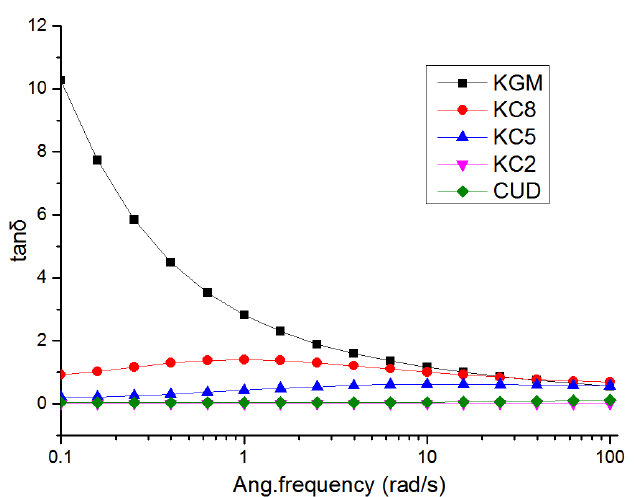
Figure 3. Curve showing the variation in tanδ for the KGM/CUD blend system at different angular frequencies.